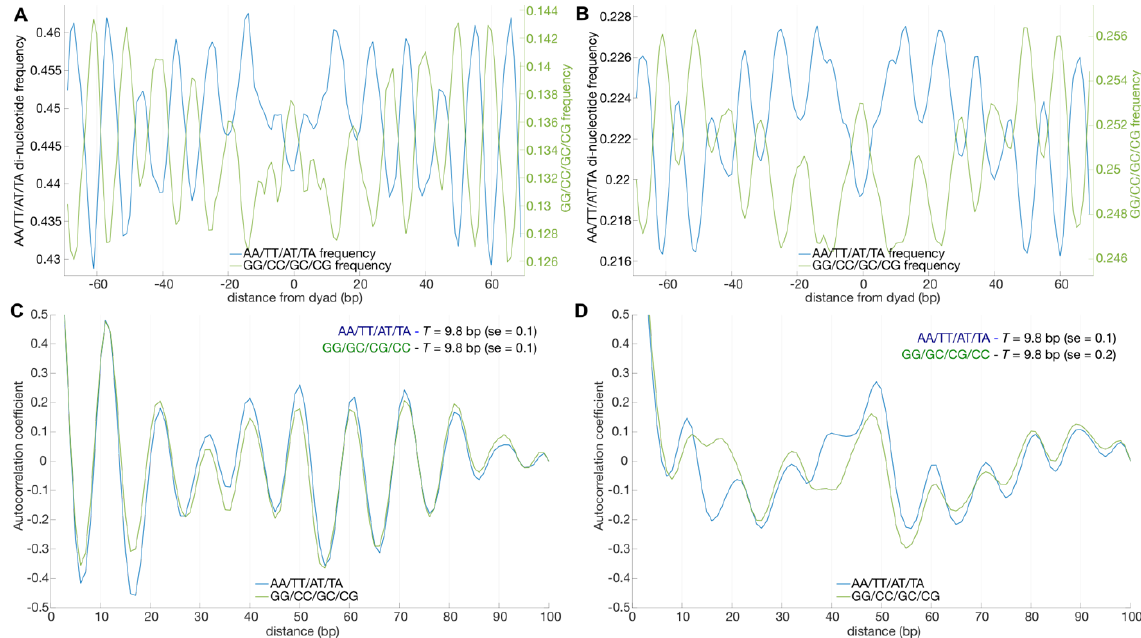
Supplementary Figure 8. Repeated di-nucleotide patterns in nucleosomal DNA located in AT-rich and GC-equilibrated regions of Leptosphaeria maculans ‘brassicae’. A and B . Normalized di-nucleotides frequency plots (average of three biological replicates) for nucleosomal DNA in AT-rich regions ( A ) and GC-equilibrated regions ( B ). C and D . Autocorrelation coefficients of di-nucleotides frequencies (average of three biological replicates) for nucleosomal DNA in AT-rich regions ( C ) and GC-equilibrated regions ( D